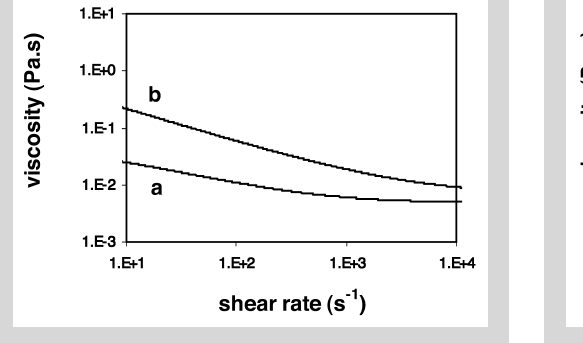
Figure 14 (left): Steady viscosity versus g · (Curve drawing limited is adapted to the experimen- tal domain 10 < g · <10 4 ):